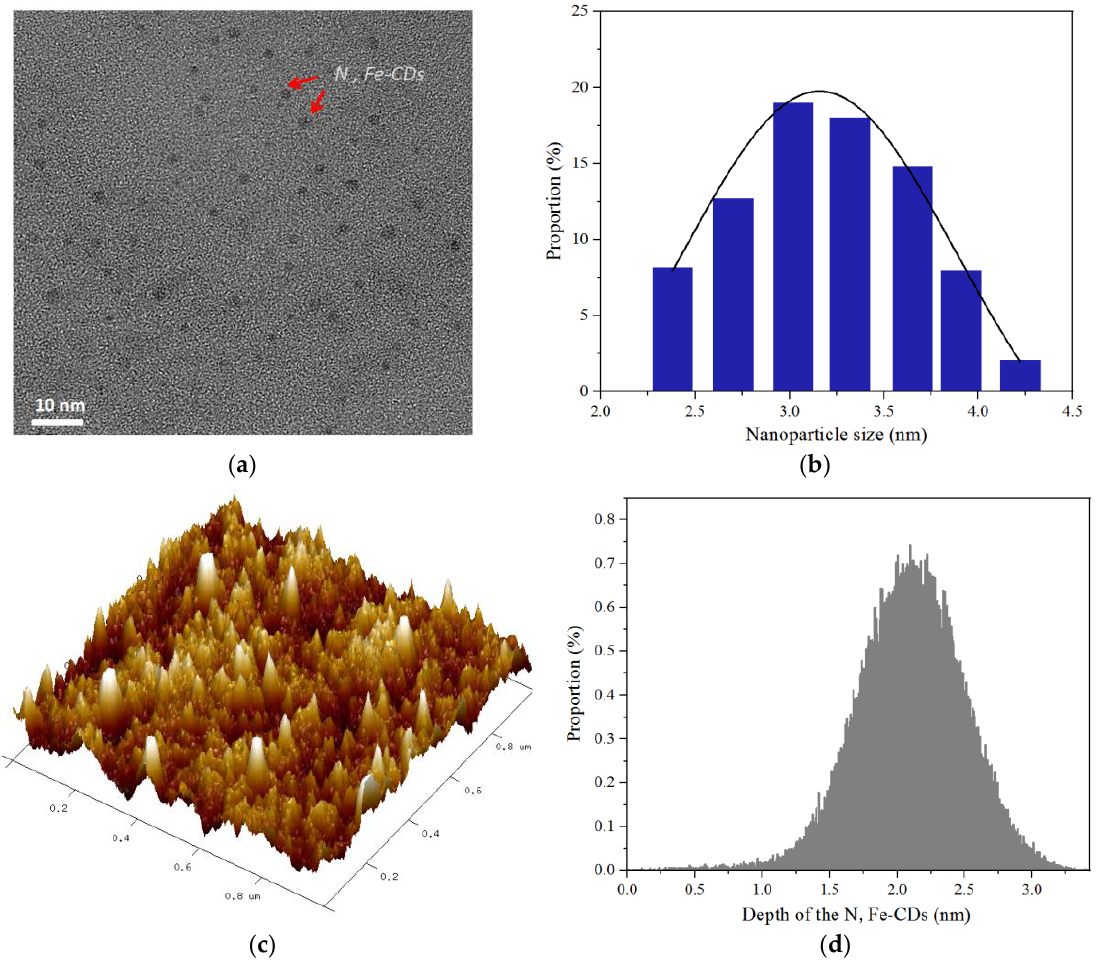
Figure 3. Morphology and size distribution of N,Fe-CDs, ( a ) TEM morphology, ( b ) Size distribution by zetasizer, ( c ) 3D AFM morphology, and ( d ) Size distribution by AFM.